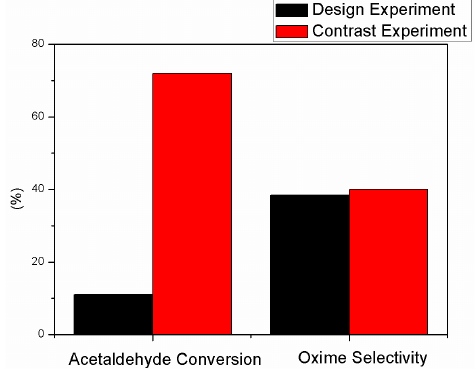
Figure 3. Comparison of the two groups of experimental results.